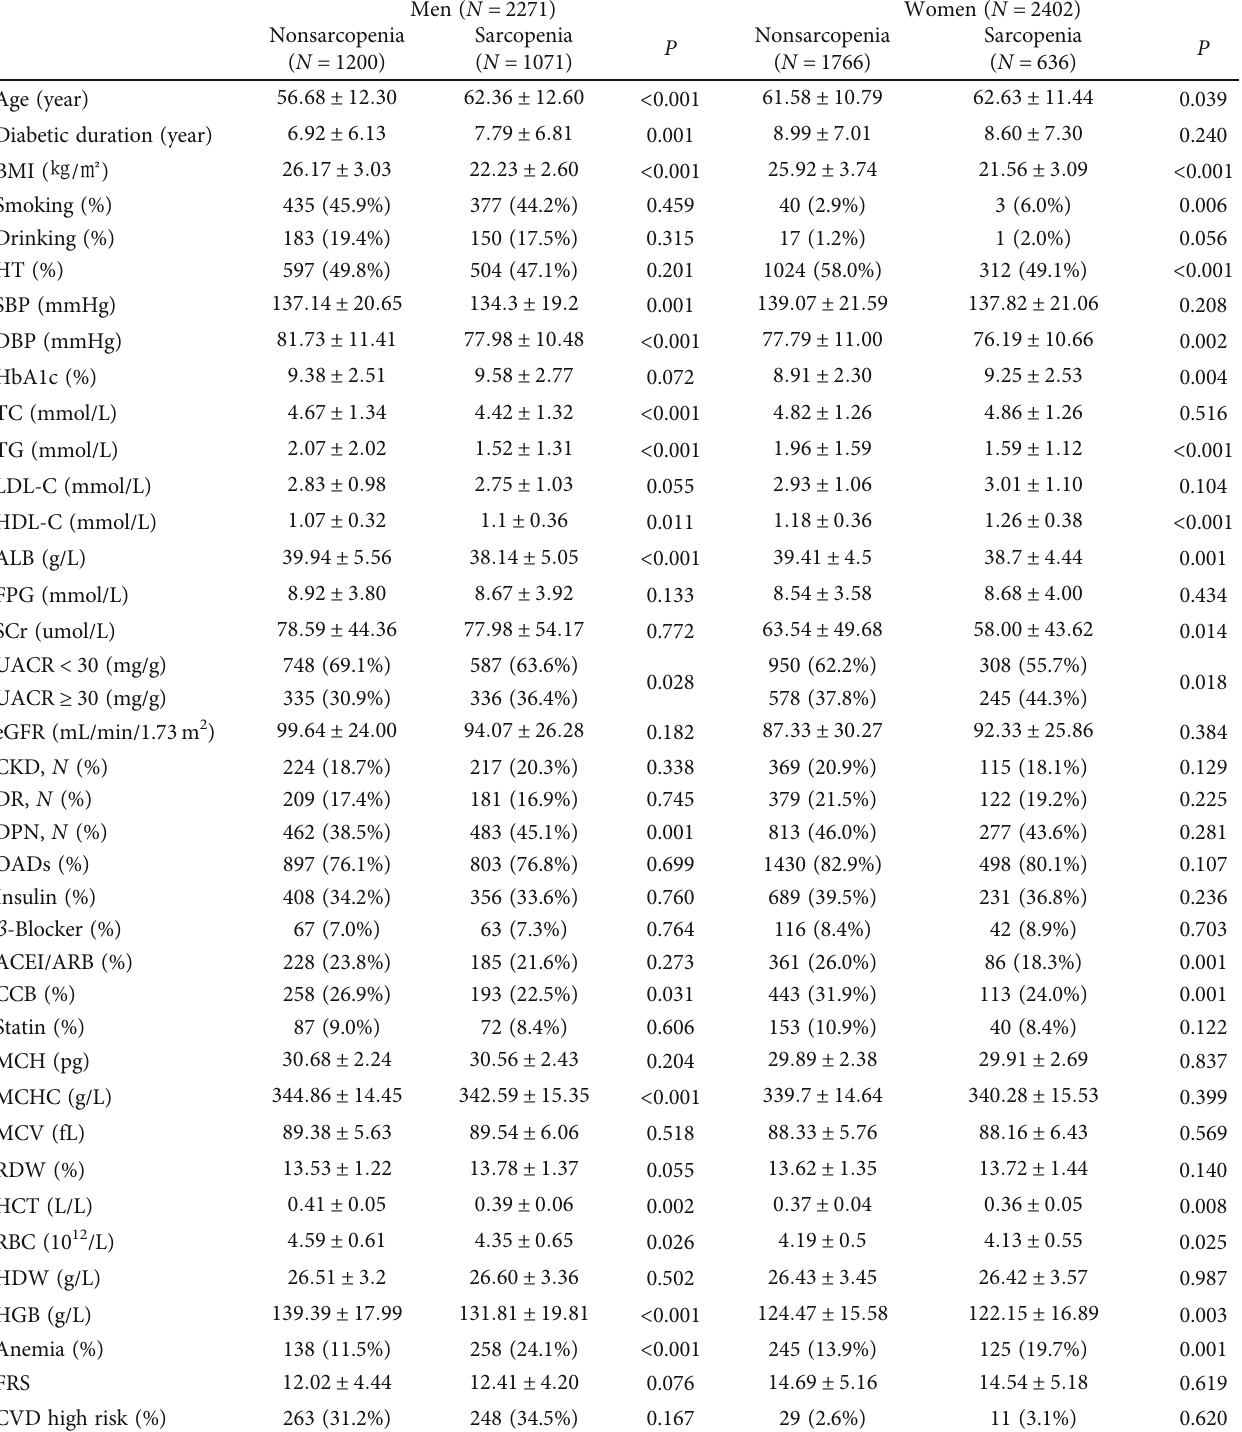
Table 1: Baseline characteristics according to the presence of sarcopenia and